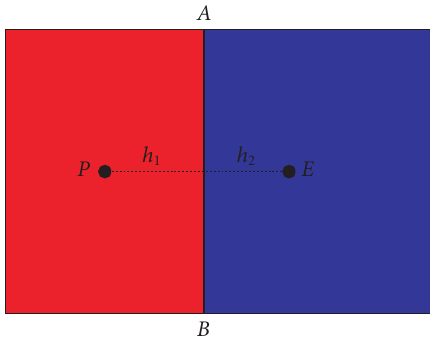
Figure 2.2 . Flux (cid:2) AB through the interface AB shared by the cells P and E ; see (2.5).